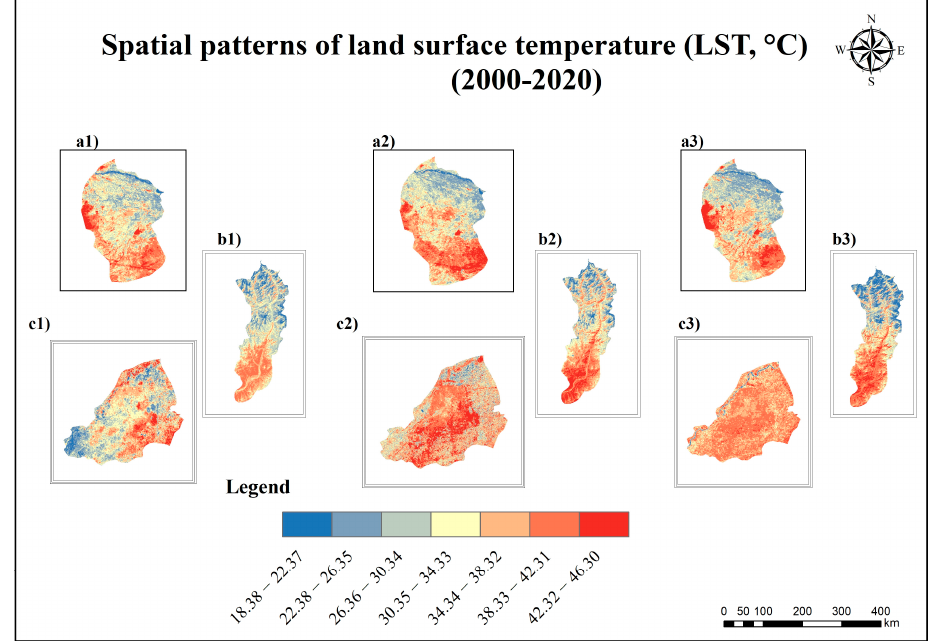
Figure 6. Spatial patterns of LST over sites a, b, and c from 2000–2020: ( a1 ) Peshawar 2000, ( a2 ) Peshawar 2010, ( a3 ) Peshawar 2020; ( b1 ) Swat 2000, ( b2 ) Swat 2010, ( b3 ) Swat 2020; ( c1 ) Lahore 2000, ( c2 ) Lahore 2010, and ( c3 ) Lahore 2020.Furthermore, we calculated the NDVI to highlight the relation of the green fraction with LST; the results are presented in Figure 7. 3.3. Spatial Patterns of Normalized Difference Vegetation Index (NDVI) To further analyze the relationship between LST and NDVI, we calculated the spatial patterns of NDVI (Figure 7) to build a linear regression between LST and NDVI (Figure 8; Table 4) over the sites (a, b, and c).